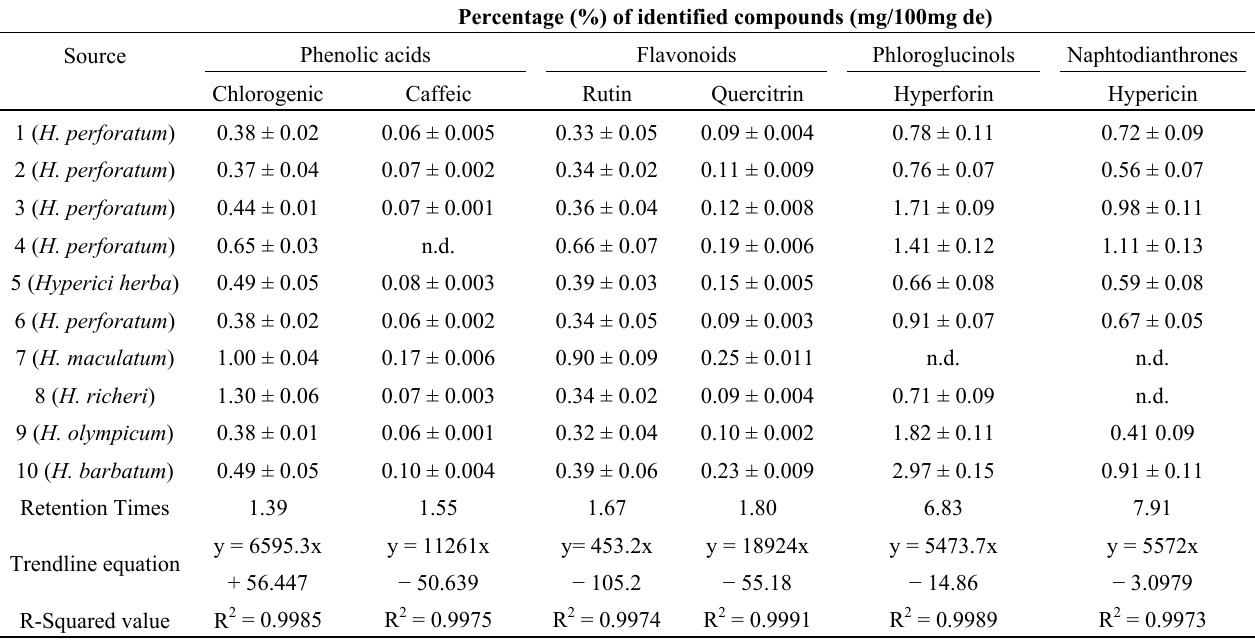
Table 2. Phenolic composition of investigated Hypericum species extracts (HPLC analysis).